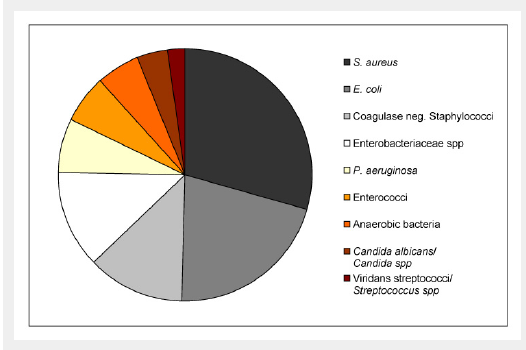
Microbiological results of 129 surgical site infections. Conclusive microbiological evaluation was achieved in 129 of 293 SSI (44%). The identified germ spectrum revealed S. aureus in 29.5% , E. coli in 20.9% , Coagulase neg. Staphylococci in 12.4%, Enterobacteriaceae spp in 12.4%, P. aeruginosa in 7.0%, Enterococciin 6.2%, anaerobic bacteriain 5.4%, Candida albicans/Candida spp in 3.9% and Viridans streptococci /Streptococcus spp in 2.3%. No antimicrobial-resistant pathogens were detected in this